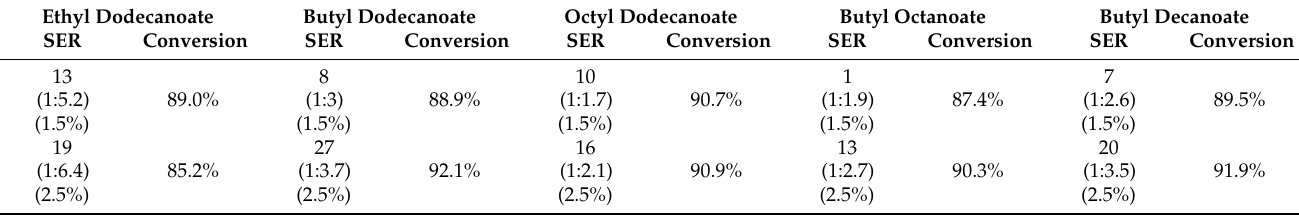
Table 5. Enzymatic syntheses of ethyl, butyl, and octyl dodecanoate, butyl octanoate, and butyl decanoate in different reaction conditions, respective SER, and conversion